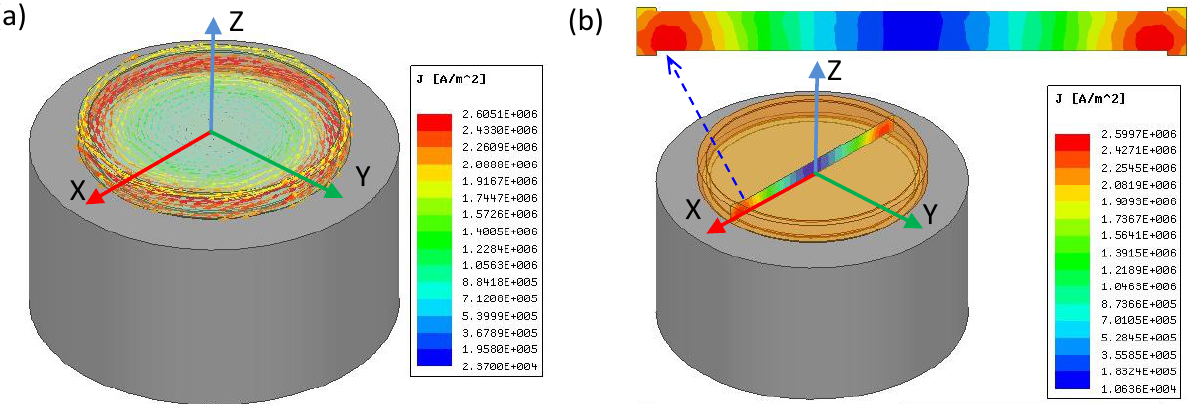
Figure 7. Simulated eddy current distribution in the coin at 0.5 ms after the excitation current pulse is applied: ( a ) current density vectors inside the coin; ( b ) intensity of current density on the central cross section of the coin. The horizontal range for the cross section is 28 mm.